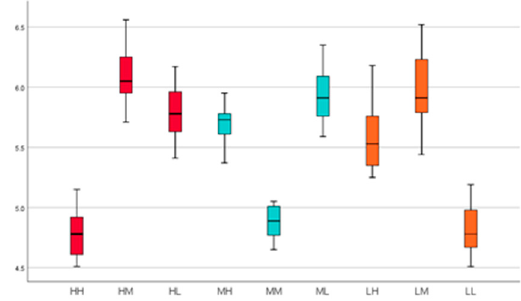
Figure 13. Wireframe diagram of each group of time data (Red represents the indication of high pitch, cyan represents the indication of medium pitch, and orange represents the indication of low pitch. H, M, and L in the group name refer to high, medium, and low, respectively; those located in front are the pitch, and those behind are the heights).